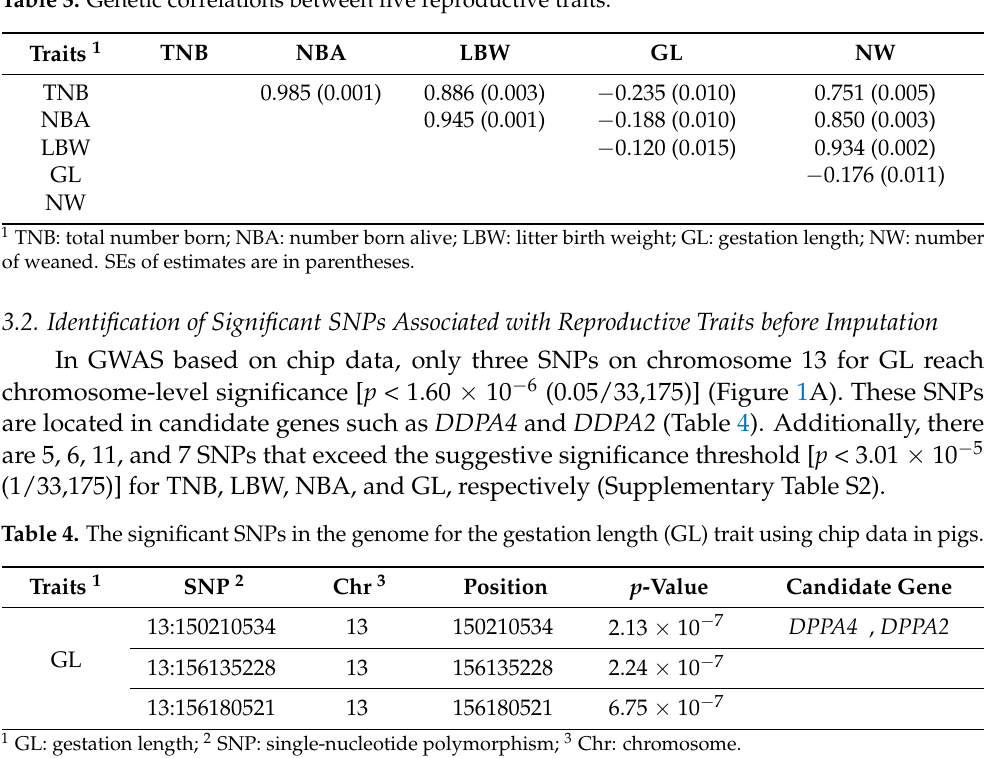
Table 3. Genetic correlations between five reproductive traits.